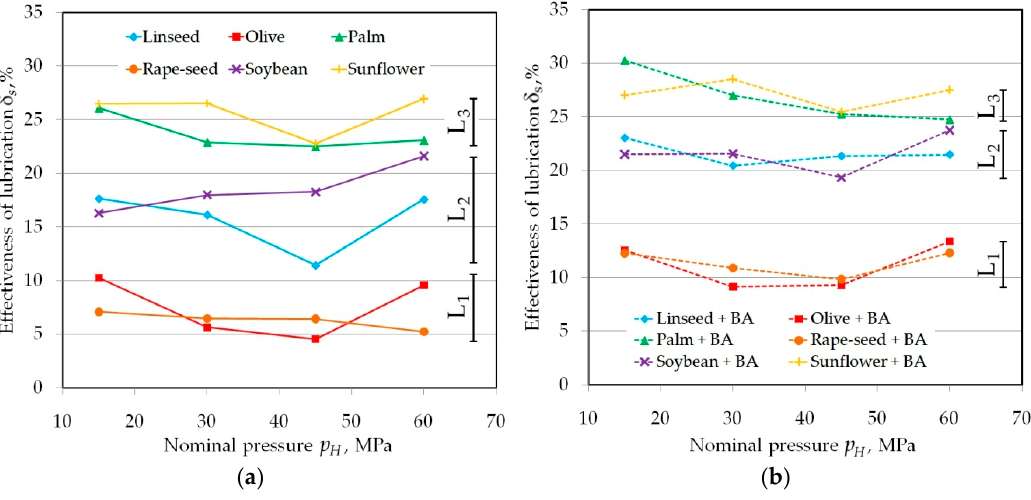
Figure 7. The effectiveness of lubrication using ( a ) pure vegetable oils and ( b ) vegetable oils with added BA in tests carried out under a range of nominal pressure between 15 and 60 MPa for a roll roughness of Ra = 0.32 m.